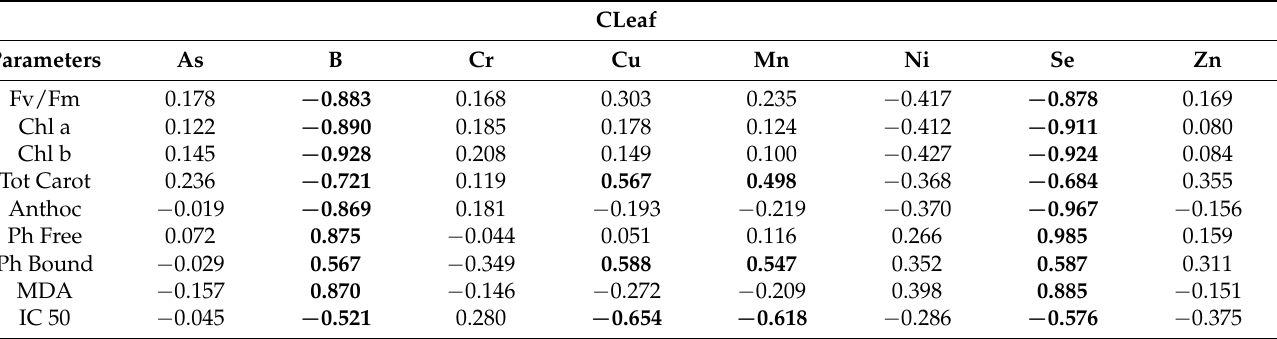
Figure 5. Very rare cases of leaf chlorosis were observed on individuals from the Control site (Figure 5A), with more pronounced chlorosis on individuals at L1 (Figure 5B,C); at L2 though, the chlorotic damage on leaves was much more intense, together with ne- crotic changes of varying intensity and sharp transitions between healthy and damaged tissue (Figure 5D–G).